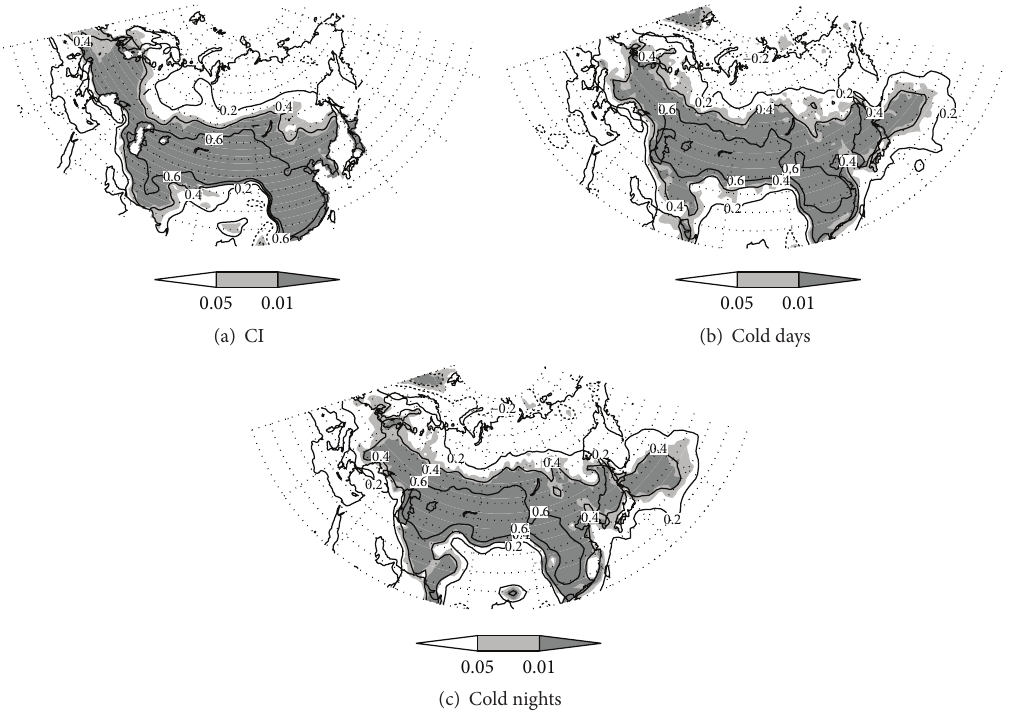
Figure 3: Correlation coefficients between ECI and the coldness intensity (CI) (a) and frequency of station-based cold days (b) and cold nights (c). The shading indicates areas with significant two-tailed Student’s 𝑡 -test exceeding 0.05 and 0.01.